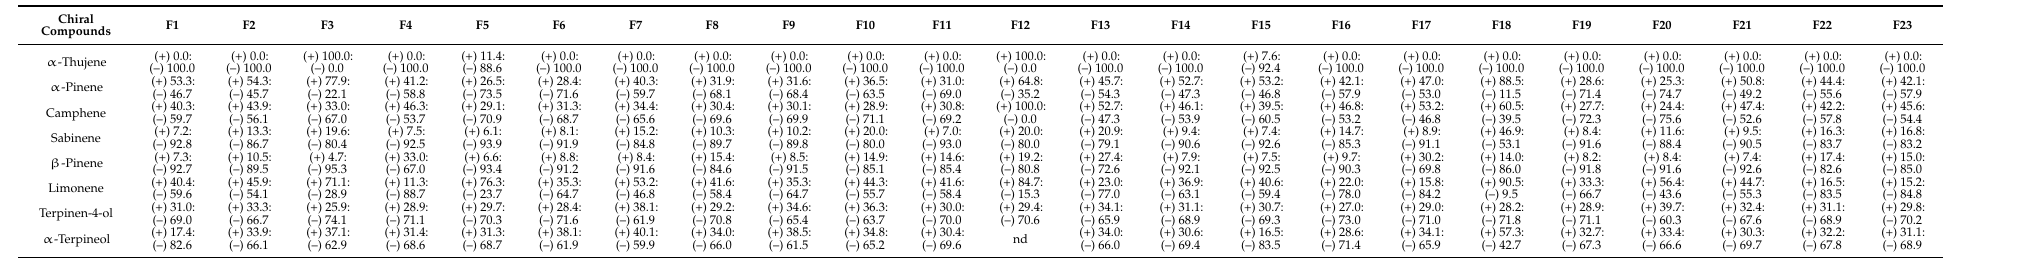
Table 2. The enantiomeric distribution of chiral terpenoids present in the commercial and lab-distilled B. carteri essential